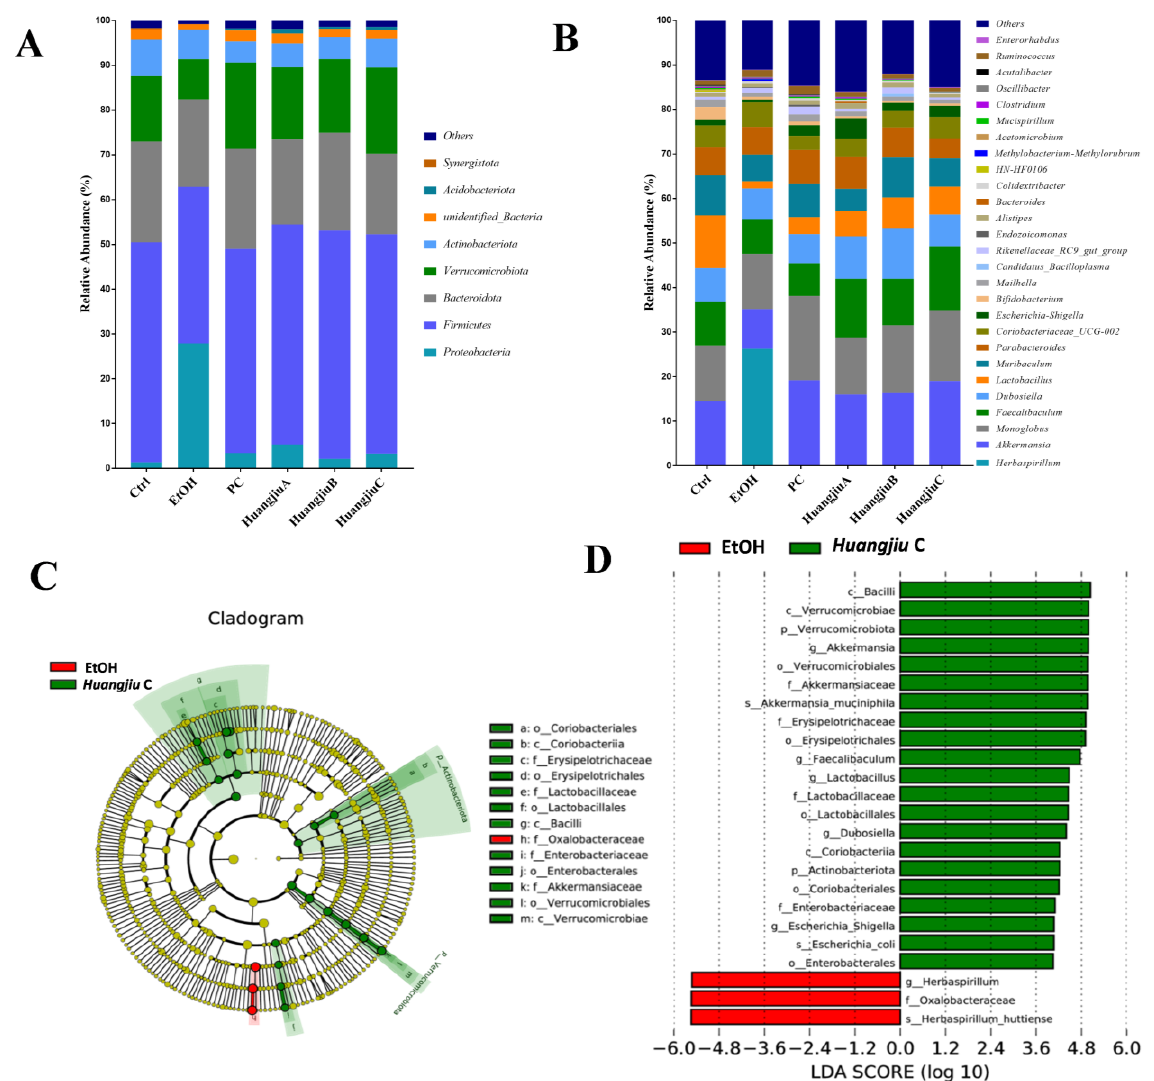
Figure 5. Effects of Huangjiu interventions on gut microbiota profiles. ( A ) Gut microbiota composition at the phylum level. ( B ) Gut microbiota composition at the genus level. ( C , D ) LEfSe comparison of gut microbiota between EtOH and Huangjiu C groups.